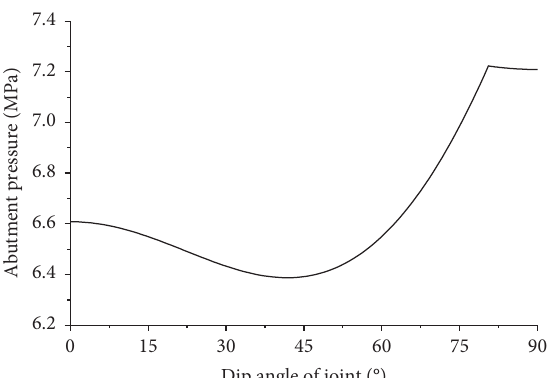
Figure 11: Change in abutment pressure in LEZ with inclination angle of joints in a fully mechanised working face with a large mining height.